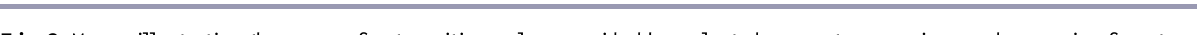
Fig. 3 . Maps illustrating the areas of net positive value provided by selected ecosystem services under passive forest restoration scenarios for each of the four study areas: (A) El Tablon, Mexico; (B) Central Veracruz, Mexico; (C) Nahuel Huapi, Argentina; (D) Quilpue, Chile. Maps are represented for a 20-year time horizon at 5% discount rate. Higher values are illustrated in red, and lower values in yellow. Note that in the case of Map C, large areas of the study area are illustrated as white, indicating net values of zero. Source: Newton